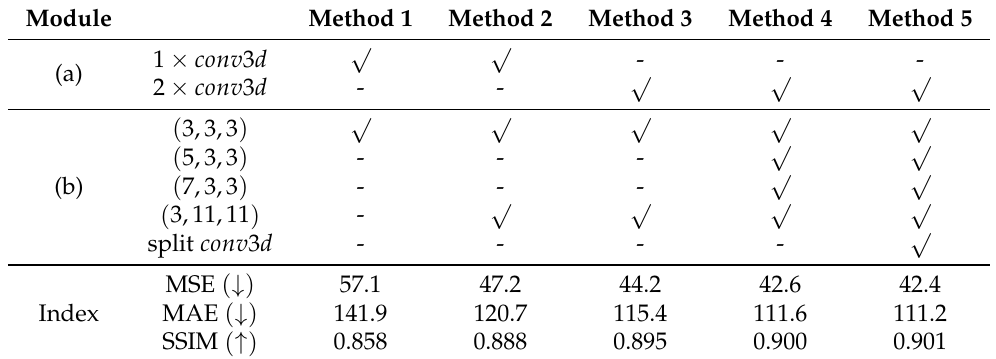
Table 6. The ablation experiment results of MSSTNet’s different modeling training for 50 epochs.